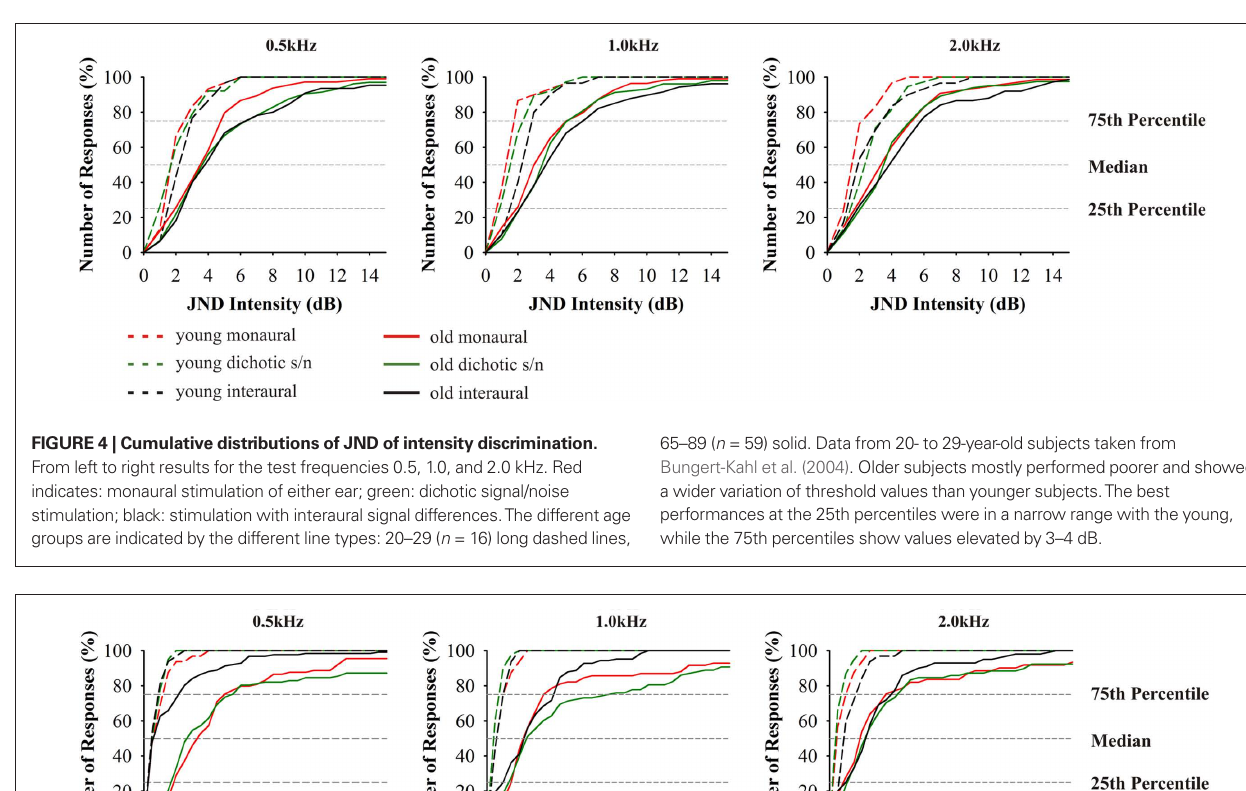
ear; green: dichotic signal/noise stimulation; black: stimulation with interaural signal differences. The different age groups are indicated by the different line types: 20–29 ( n = 16) long dashed lines, 65–89 ( n = 59) solid. Most prominently, performances depended on test alternative, frequency, and age. Variance increased in